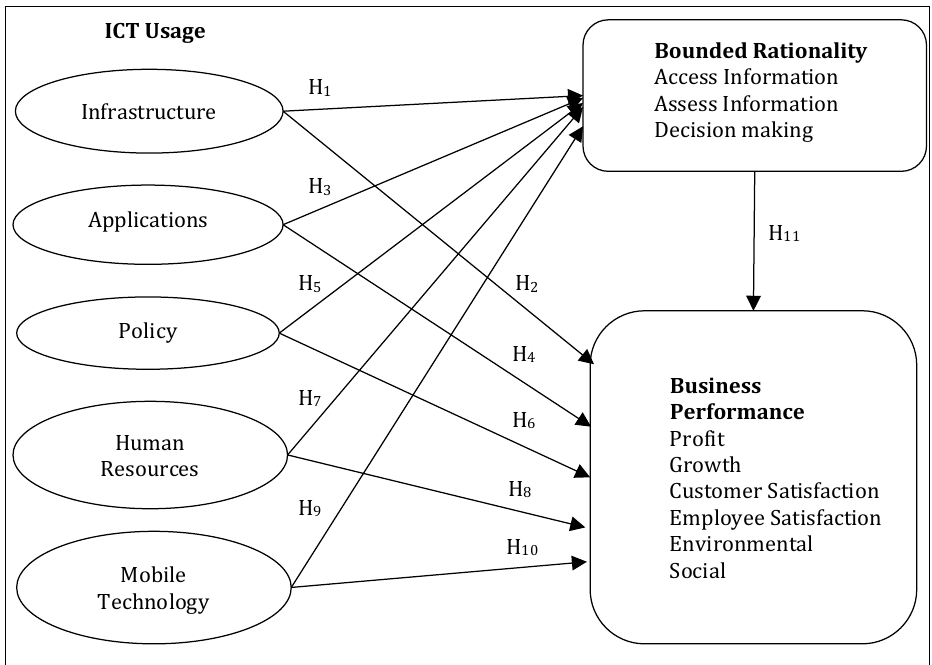
Figure 1: Conceptual